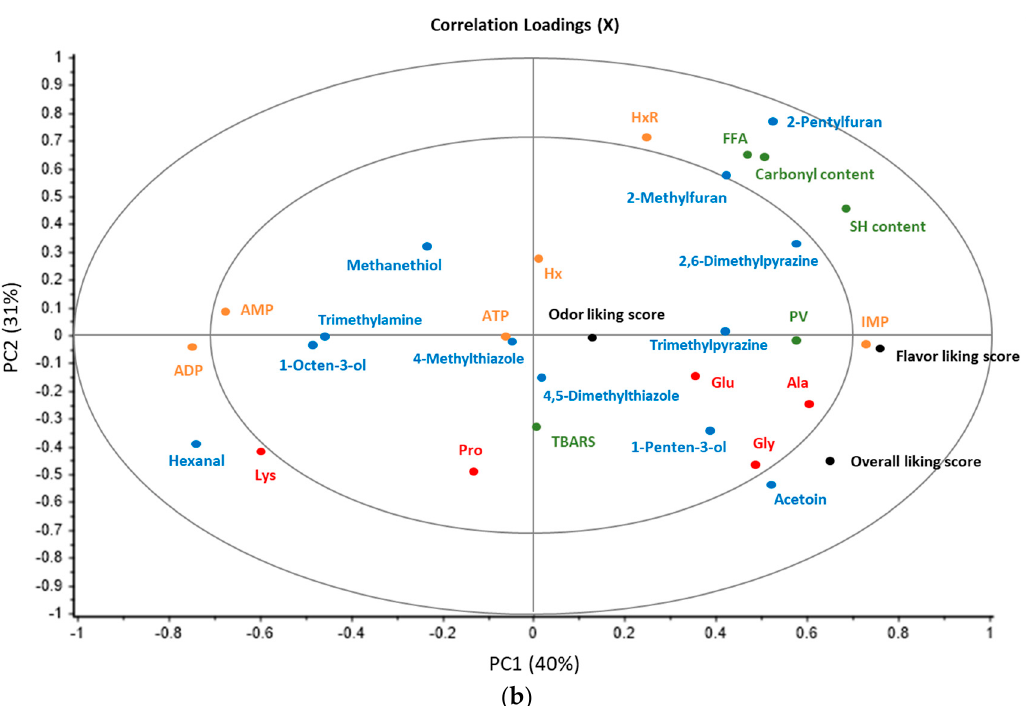
Figure 2. PCA score plots ( a ) and correlation loading (protein/lipid oxidation products (green color), some free amino acids (red color), some volatiles (blue color), ATP-related compounds (orange color) and sensory scores (black color)) plots ( b ) of SV-cooked tilapia processed by various SV con- ditions.